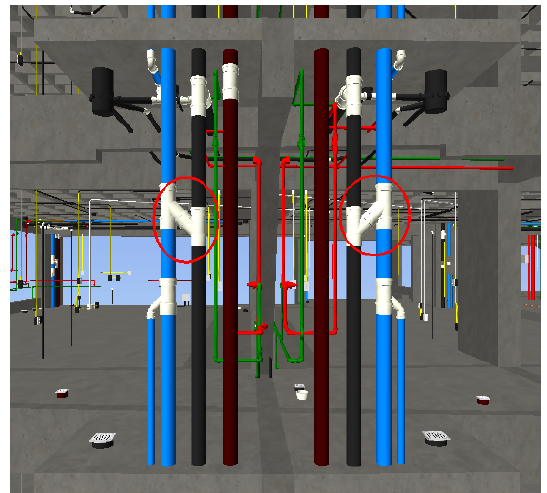
Figure 2: Needed distance correction between ventilation and sani- tary